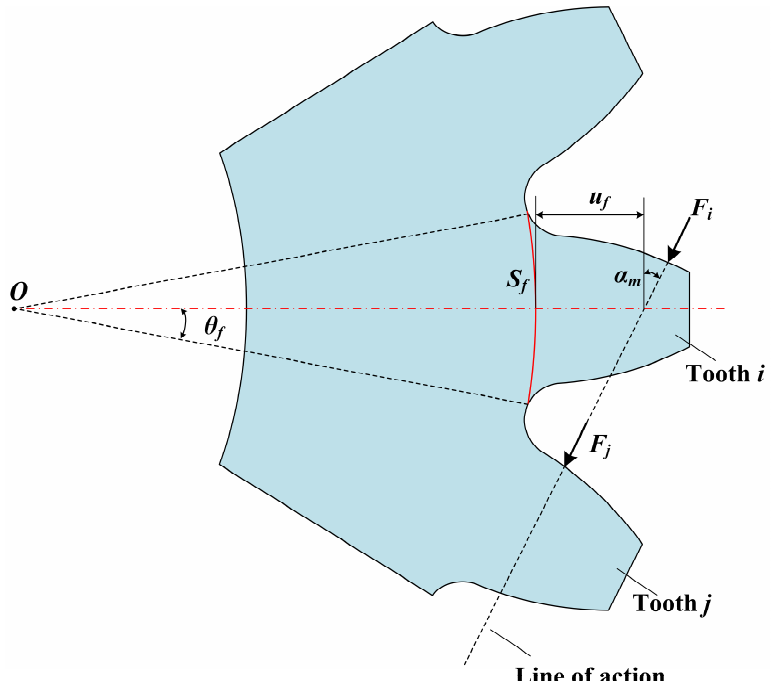
Figure 3. Fillet-foundation deflection and gear body structure coupling deflection.